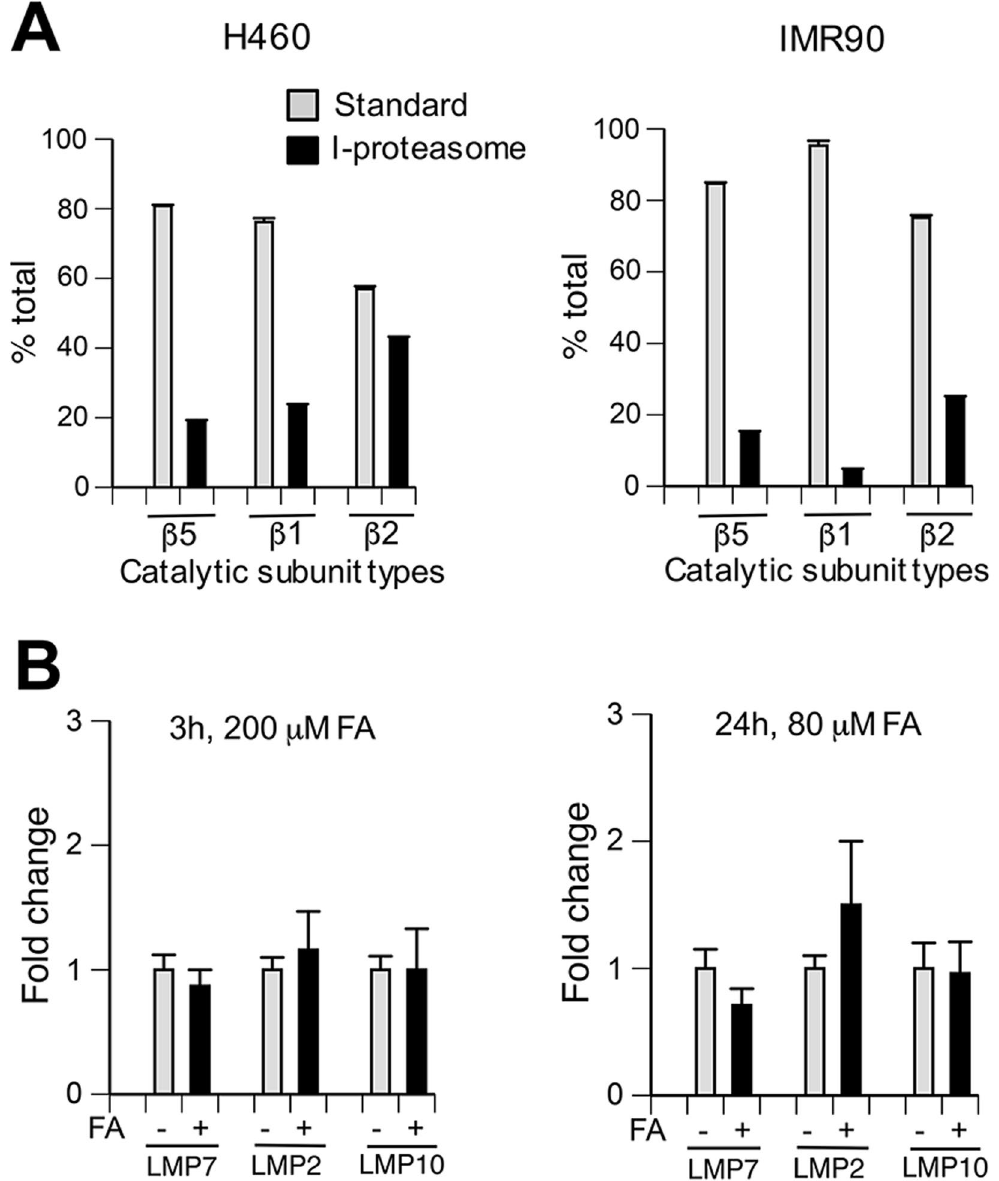
Figure 1. qRT-PCR for catalytic proteasomal subunits. Data are means ± SD for three independent RNA samples. Where not seen, error bars were smaller than symbols. ( A ) Relative amounts of standard and i-proteasomal subunits within three types of catalytic activities ( β 5: PSMB5 and LMP7, β 2: PSMB6 and LMP10, β 1: PSMB7 and LMP2). ( B ) Gene expression of i-proteasome subunits is not altered by FA treatments in normal IMR90